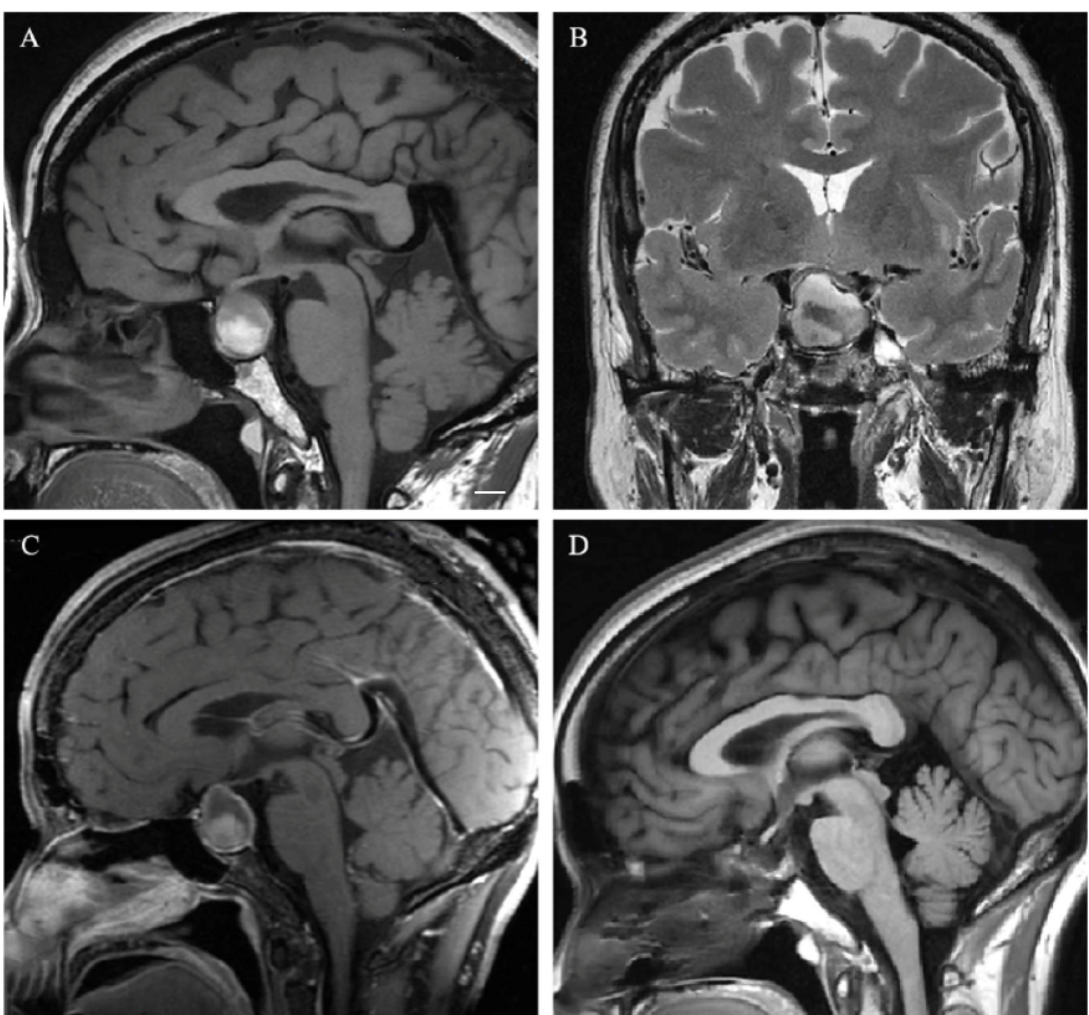
Figure 4. A 63-year-old female with sudden vision loss for three days with preoperative panhypopituitarism. Intrasellar mixed signs are shown on preoperative T1 and T2 weighted imaging ( A , B ), and heterogeneous enhancement on T1-weighted contrast-enhanced MR image ( C ). The tumor without hypothalamic involvement (Puget grade 0) was totally resected through transsphenoidal surgery, and the pituitary stalk was completely retained ( D ). Visual loss and hypopituitarism were corrected after surgery. Scale bar: 1 cm.